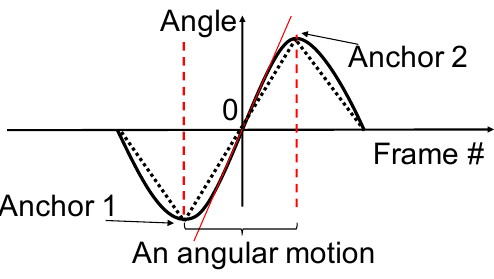
Figure 8. Example of a First-Person